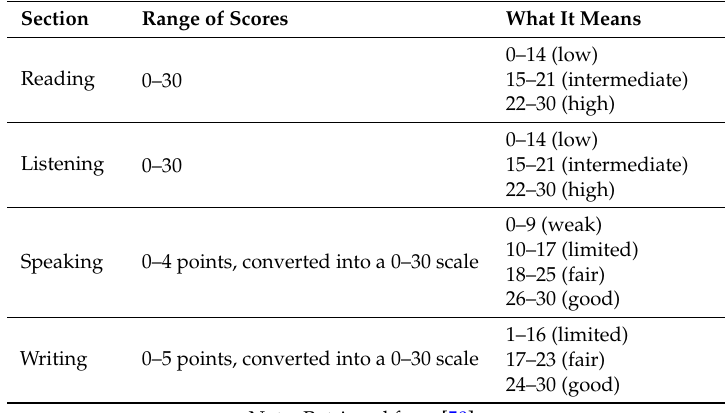
Table 1. TOEFL iBT score